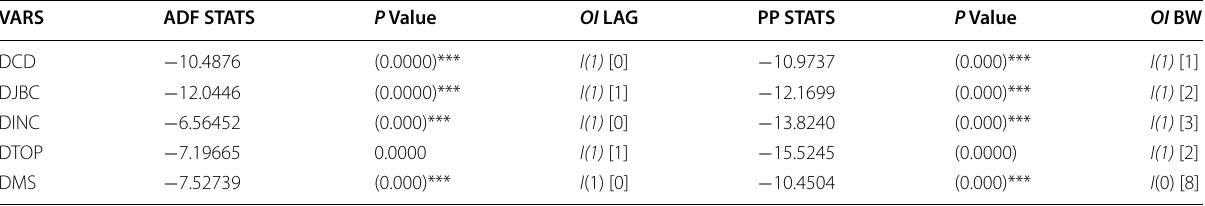
Source Computed using Eviews 9.0